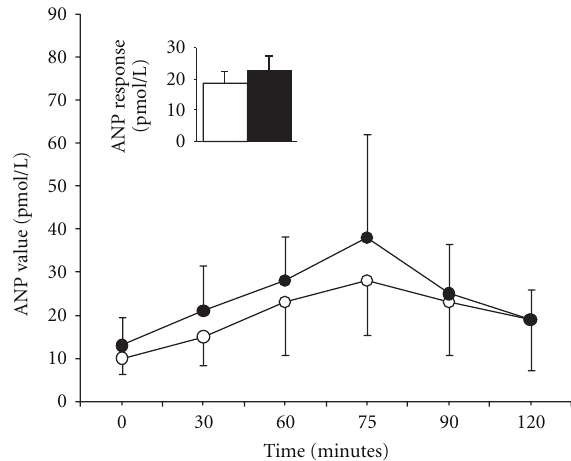
Figure 1: Mean (+SD) ANP values following administration of normal saline. The lines represent subjects before T 3 (open circles) and after T 3 administration (black circles). The mean integrated AUC values together with SEM are shown in the insets, with bars representing subjects before (white) and after T 3 administration (black) (ANP units pmol/L.h). There was no di ff erence in the integrated AUC values when responses before and after T 3 administration were